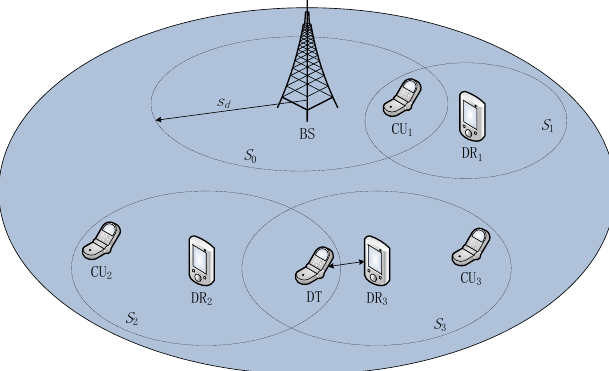
Figure 5. Model of the distance-aware link selection algorithm. In the figure, all the devices are serviced in the same cell by the same base station (BS).